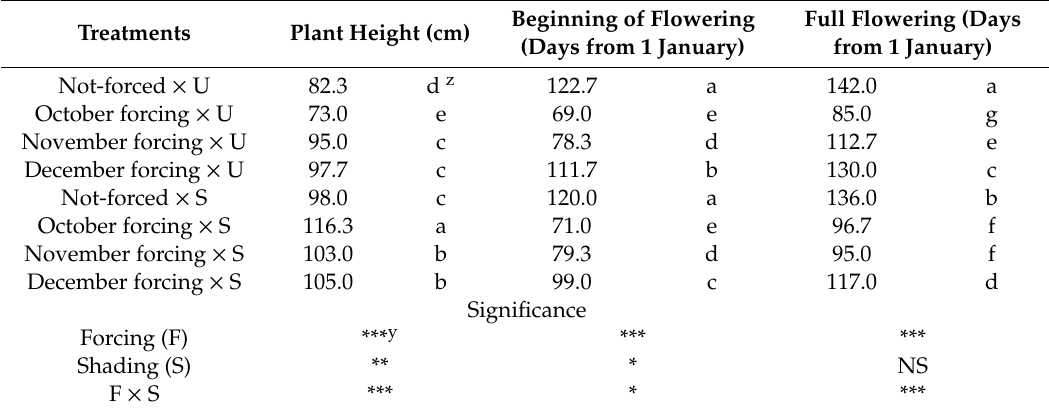
Beginning of Flowering Full Flowering (Days (Days from 1 January) from 1 January)